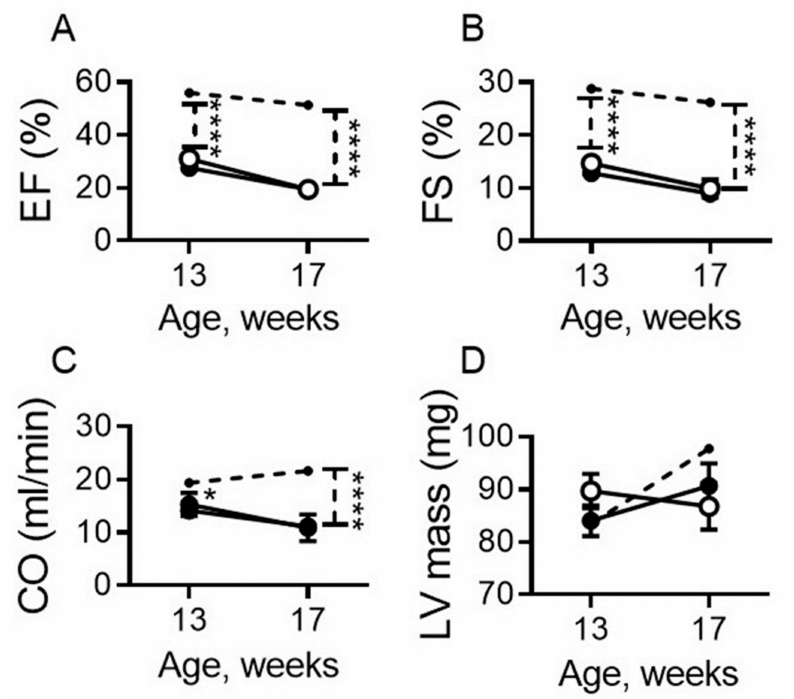
Figure 3. Dietary sodium restriction does not modulate cardiac systolic function in mice with DCM. ( A – D ) Age-related changes in left ventricular systolic function measured as ejection fraction (EF; A ), fractional shortening (FS; B ), cardiac output (CO; C ), and left ventricle mass (LV mass; D ). DCM mice on LSD (closed symbol) or NSD (open symbol) (enrollment n = 11–14 per group), and WT mice (dashed line, n = 8–10). Data are presented as mean ± standard error of the mean (SEM). **** p < 0.0001, * p < 0.05 (DCM vs. WT) as determined by two-way ANOVA with Bonferroni multiple comparison